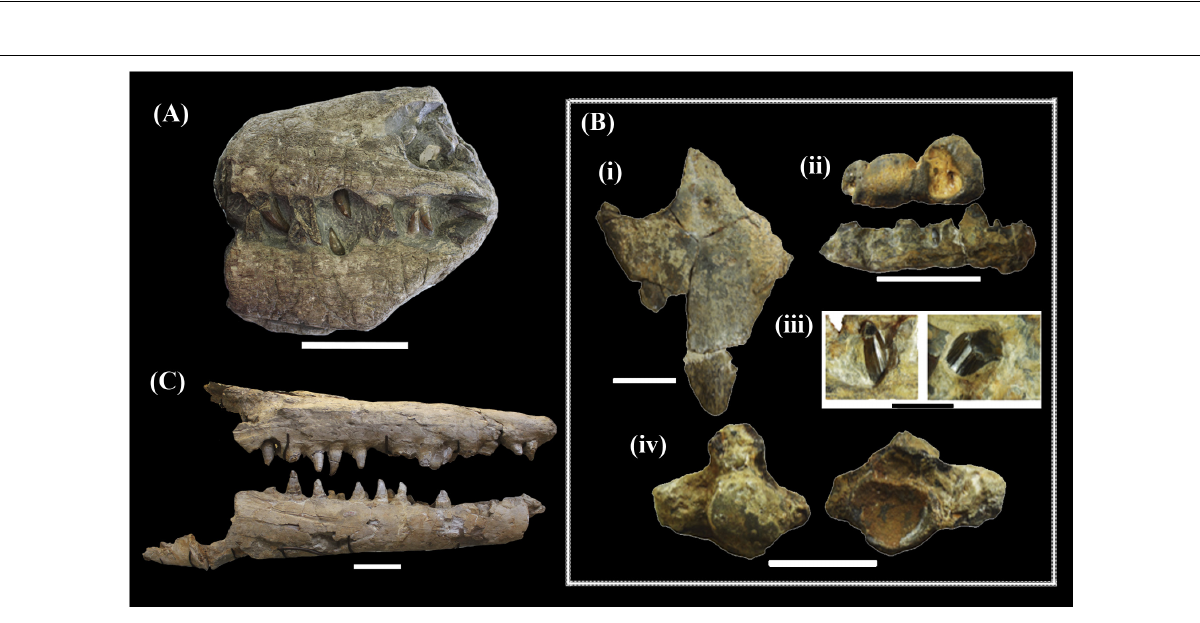
Frontiers in Earth Science |